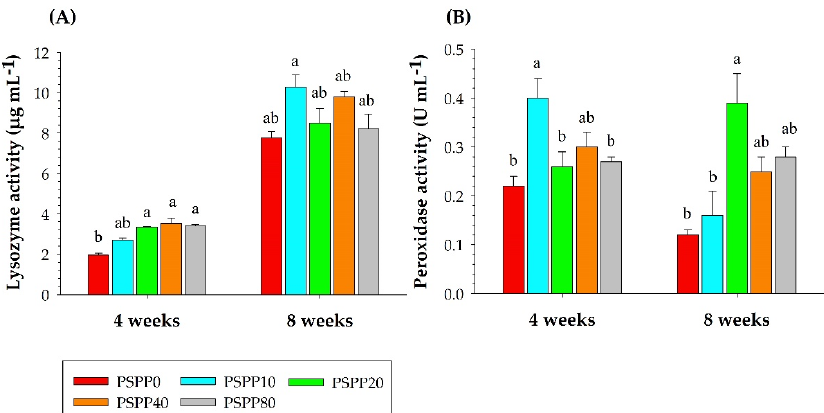
Figure 2. Lysozyme ( A ) and peroxidase ( B ) activity in the serum of Nile tilapia after four and eight weeks of feeding with experimental diets: 0 g kg − 1 (PSPP0) control, 10 g kg − 1 (PSPP10), 20 g kg − 1 (PSPP20), 40 g kg − 1 (PSPP40), and 80 g kg − 1 (PSPP80) cultivated for eight weeks. Data are presented as mean ± SE. Significantly different levels are denoted by superscript letters ( p < 0.05).